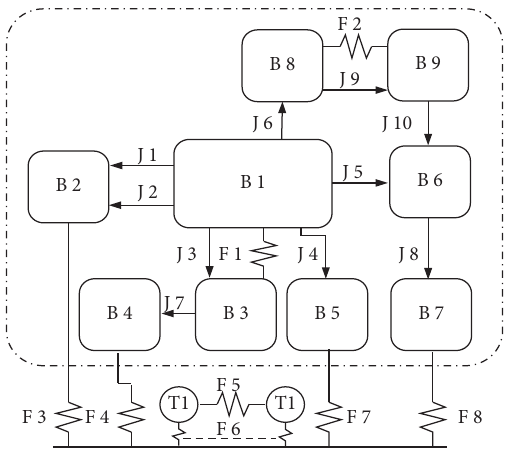
Figure 1: Topology of the complete track model. Table 2: Part list of tracked vehicle action system model. No.